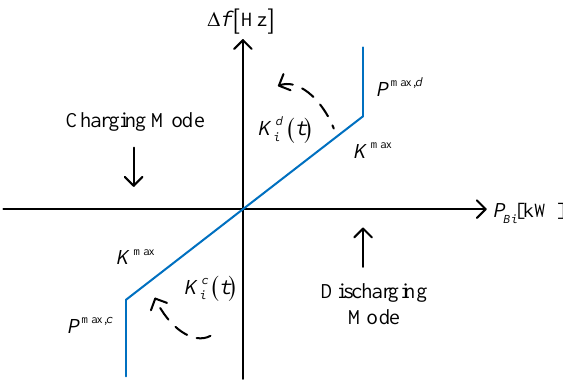
Figure 2. Adaptive frequency droop characteristic for